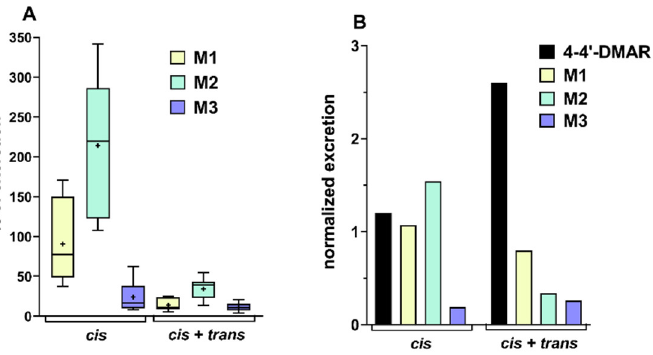
Figure 7. ( A ) Percentage ratio of excretion of M1, M2 and M3, the principal metabolites of cis -4,4 (cid:48) - DMAR for the administration of a dose of 10 mg/kg of 4,4 (cid:48) -DMAR ( cis ) and the same dose of both isomers ( cis + trans ). The box plots report maximum and minimum value, median and average (+). ( B ) Excretion data of 4,4 (cid:48) - cis -DMAR and its principal metabolites normalised to the sum of excretion of 4,4 (cid:48) -DMAR and its metabolites. Data normalised and reported, respectively, for the administration of cis or cis + trans isomers at a dose of 10